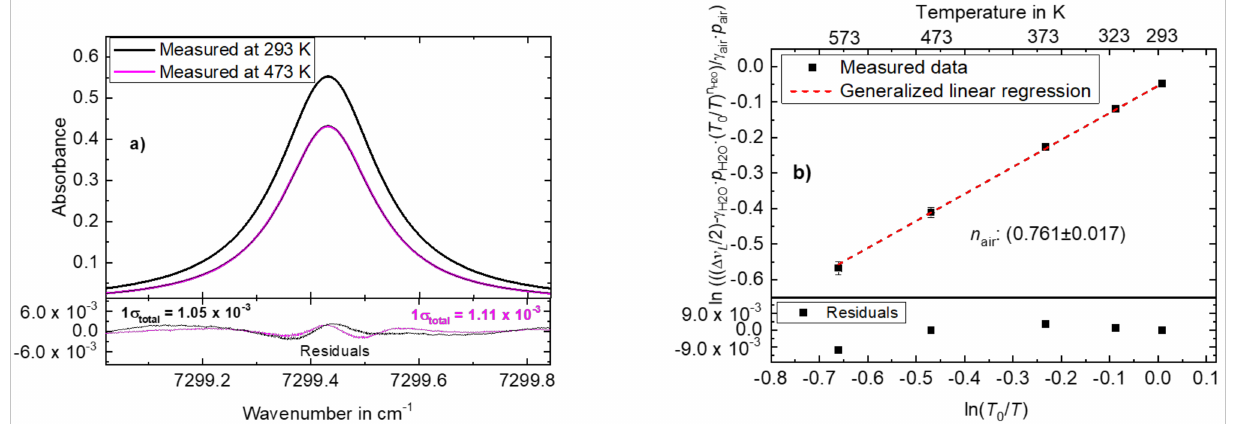
Figure 6. ( a ) Temperature dependence exponent of air broadening: absorbance data at 293 K and 473 K. ( b ) A GLR linear regression applied to measured data to determine the temperature dependence coefficient of air broadening. RMS error: 1.30 × 10 − 16